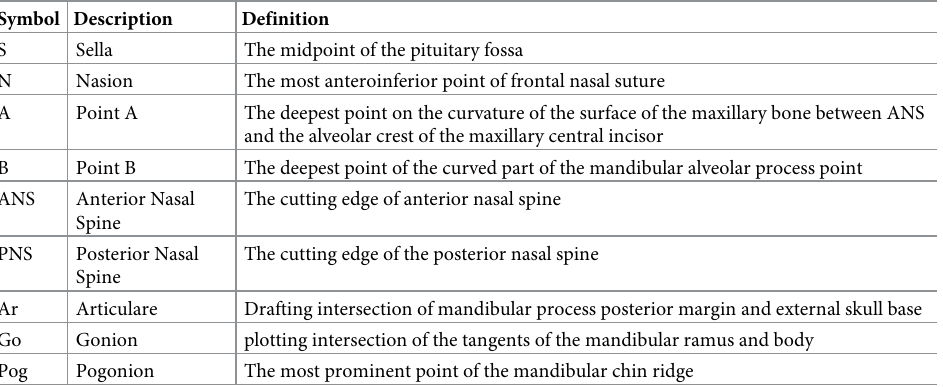
Table 2. Definitions of measurements variables.